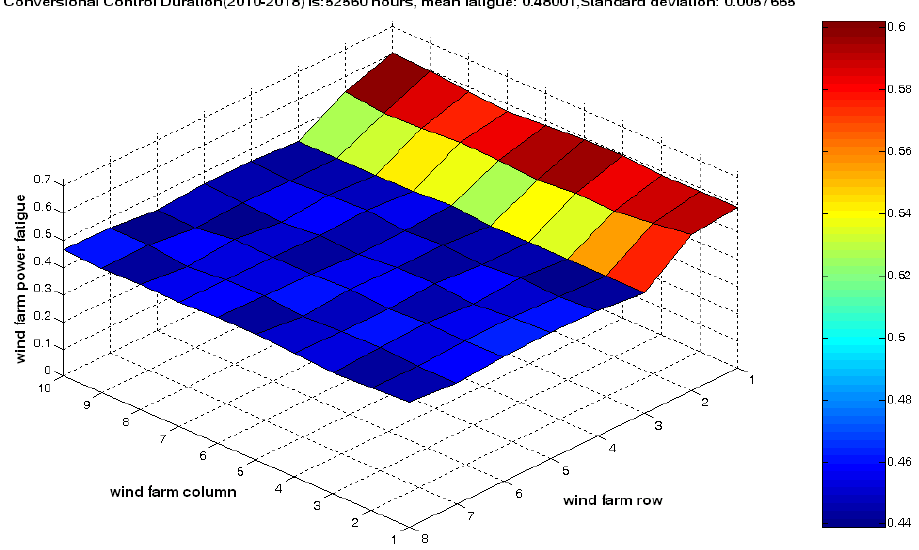
Figure 9. Farm fatigue distribution based on the Conventional Control (2010–2018, Horns Rev OWF).